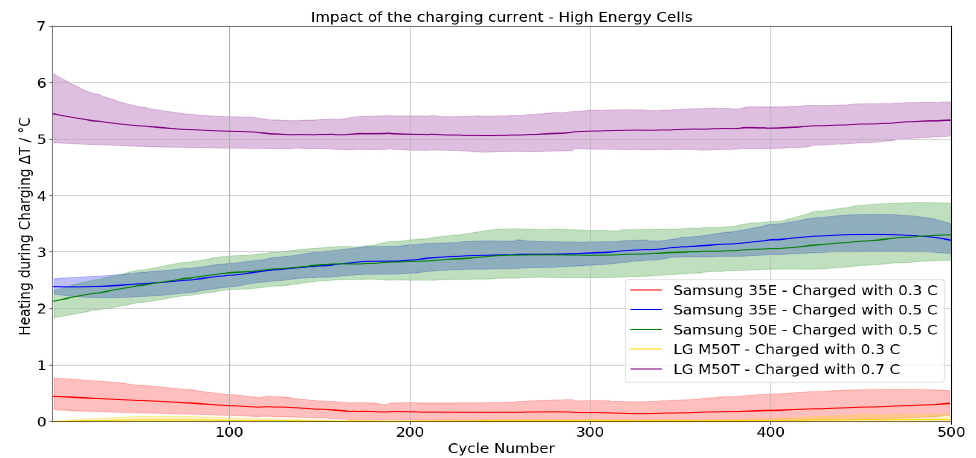
Figure 8. Development of the maximum temperature rise during the charging process of the cycle test of the high-energy cells. Solid lines represent the mean values, shaded areas represent the spread of the measured values.